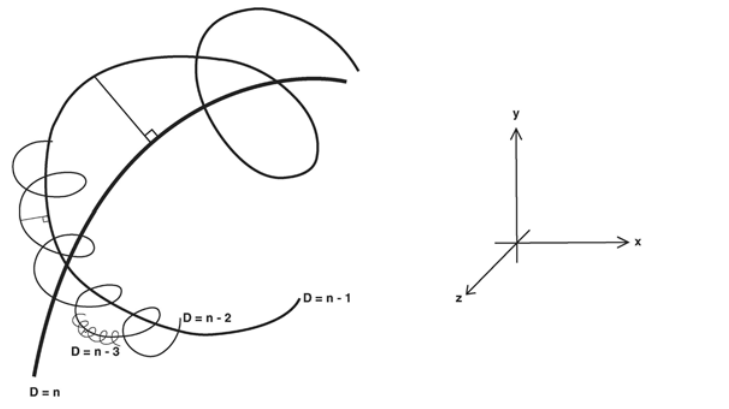
FIGURE 1AB. Shows a breakdown of the three dimensional space into an infinite number of curvilinear pseudodimensions. (A) Different fractal dimensions. (B) 3-D dimensions. D = Dimensions. n – 1, n – 2, n – 3 illustrates the different levels of